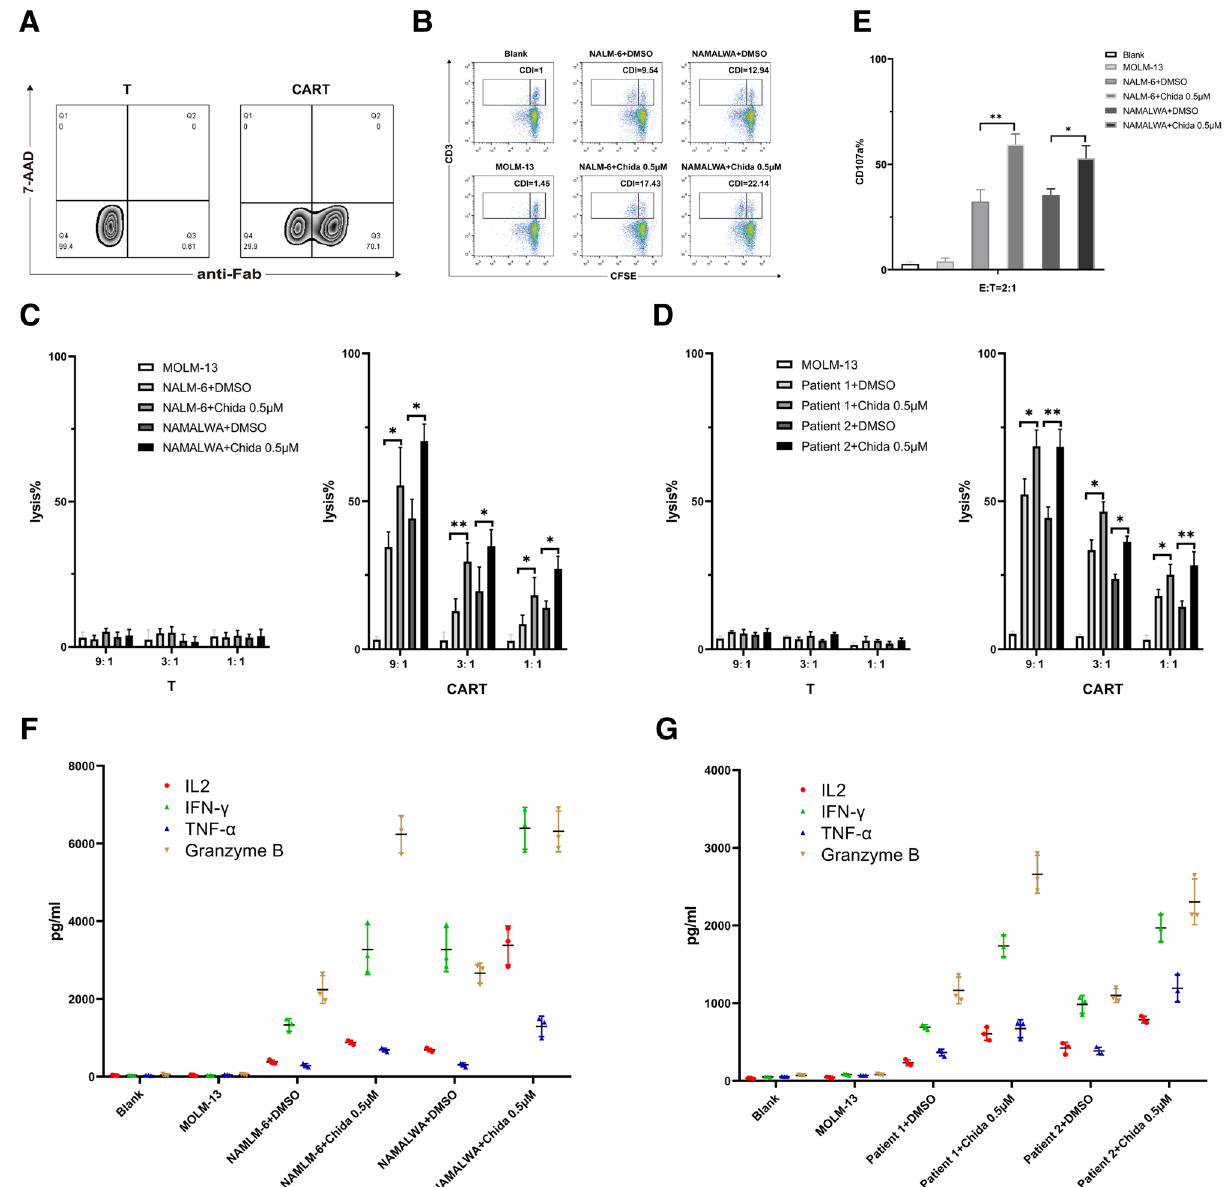
Figure 2. Chidamide enhances the functionality of CD22 CAR T Cells in vitro by upregulating cell surface CD22 expression. ( A ) Transfection rate of T cells expressing CAR22. ( B ) The expansion of CAR T cells was evaluated by CFSE. CAR T cells were stained with CFSE and co-cultured with different target cells. When conducting flow cytometry, 5000 parental cells in the right square were collected and the left square represented the progeny cells. CDI was calculated using the group of blank as a control. ( C – D ) Different target cells (MOLM13, NALM6 pretreated with DMSO or Chidamide, NAMALWA pretreated with DMSO or Chidamide, and primary cells pretreated with DMSO or Chidamide) in cytotoxicity assays at various effector: target cell ratios. Here, we show the combined results of three independent experiments. After CAR T cells were co-cultured with different target cells, the degranulation levels ( E ) were detected by flow cytometry and cytokines were measured by ELISA from cell culture supernatants ( F – G ). Statistics were calculated using unpaired